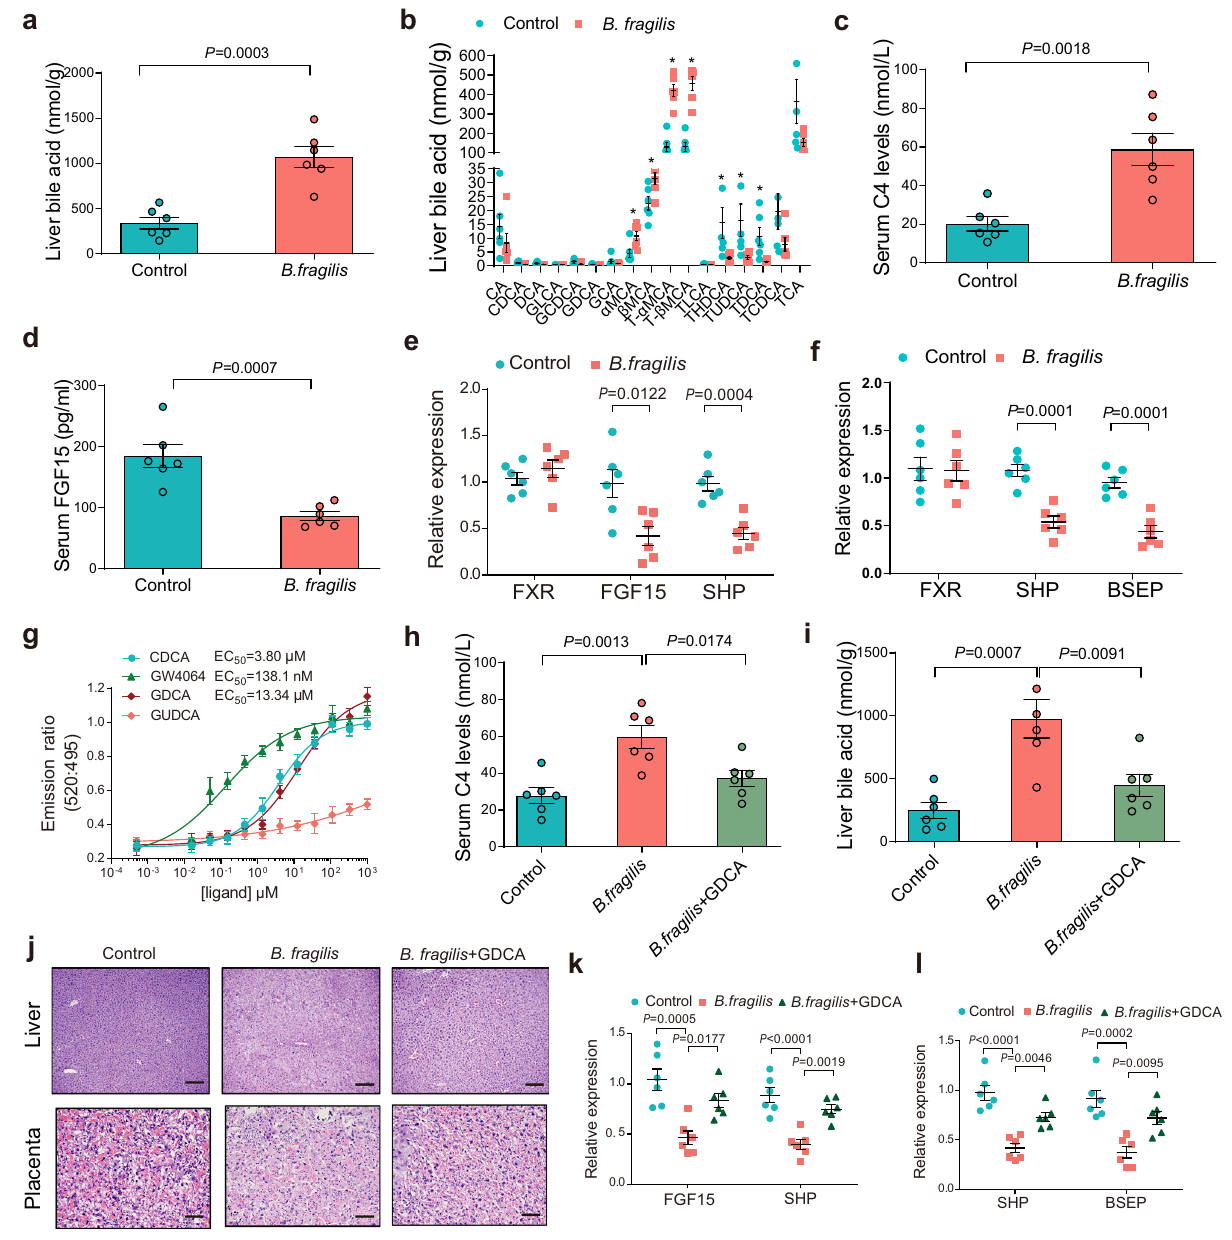
Fig. 4 | B. fragilis suppressed FXR signaling through mediating bile acid metabolism to increase hepatic bile acids accumulation. a Liver total bile acid levels in B. fragilis transplanted mice or control group ( n =6 per group). b Hepatic bileacidspro fi lesin B.fragilis transplantedmiceorcontrolgroup( n =6pergroup). P values were determined by two-tailed Student ’ s t -test for a , b . * P <0.05. c , d Serum C4 levels ( c ) and FGF15 levels ( d ) in B. fragilis transplanted mice or controlgroup( n =6pergroup). P valuesweredeterminedbytwo-tailedStudent ’ s t - test.e,fRelativeexpressionofintestinal( e )andhepatic( f )FXRmRNAanditstarget genes in mice colonized with B. fragilis or control ( n =6 per group). P values were determined by two-tailed Student ’ s t -test. g TR-FRET FXR coactivator recruitment